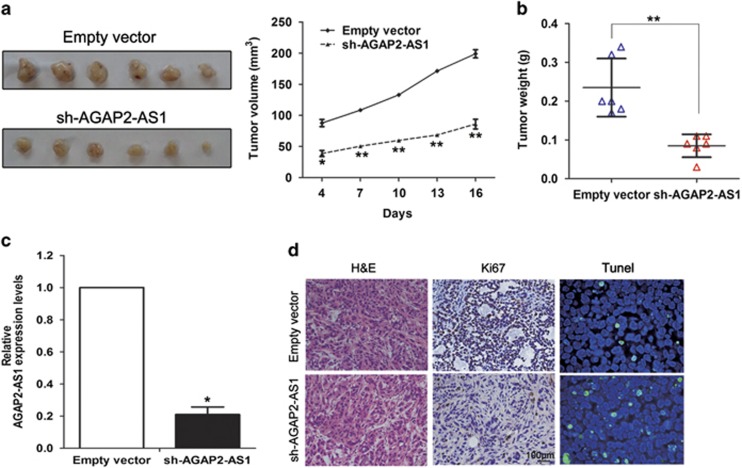
Effect of AGAP2-AS1 knockdown on tumor growth in vivo. (a) The stable AGAP2-AS1 knockdown H1299 cells were used for the in vivo study. The nude mice carrying tumors from respective groups were shown and tumor growth curves were measured 4 days after the injection of H1299 cells. Tumor volume was calculated every 3 days. (b) Tumor weight of each tumor sample form two groups are represented, and values represented the mean±S.E.M. (c) QPCR analysis of AGAP2-AS1 expression in tumor tissues formed from H1299/sh-AGAP2-AS1 and H1299/empty vector. (d) Tumors developed from sh-AGAP2-AS1-transfected H1299 cells showed lower Ki67 protein and higher Tunel staining levels than tumors developed by control cells. Left, H&E staining; middle, Ki67 immunostaining; right, Tunel staining. All experiments were performed in biological triplicates with three technical replicates and data represented the mean±S.E.M. *P<0.05, **P<0.01